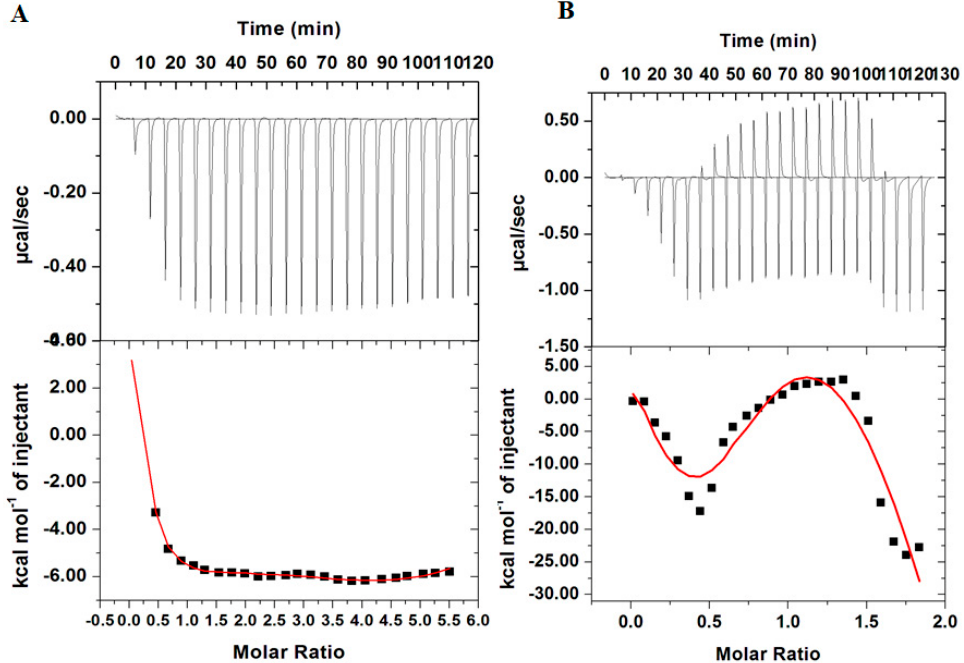
Figure 5. ( A ) Isothermal titration calorimetric profile obtained upon titration of 100 µ M DP into 20 µ M MARK4. ( B ) Isothermal titration calorimetric profile obtained upon titration of 200 µ M RT into 20 µ M MARK4. The bottom panel shows resultant binding isotherm before the integration of peak area and normalization to yield a plot of molar enthalpy change against the ligand / protein ratio.